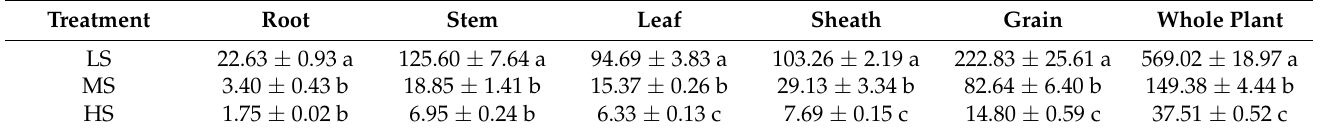
Table 2. Dry matter mass (g m − 2 ) of each wheat parts in different treatments.